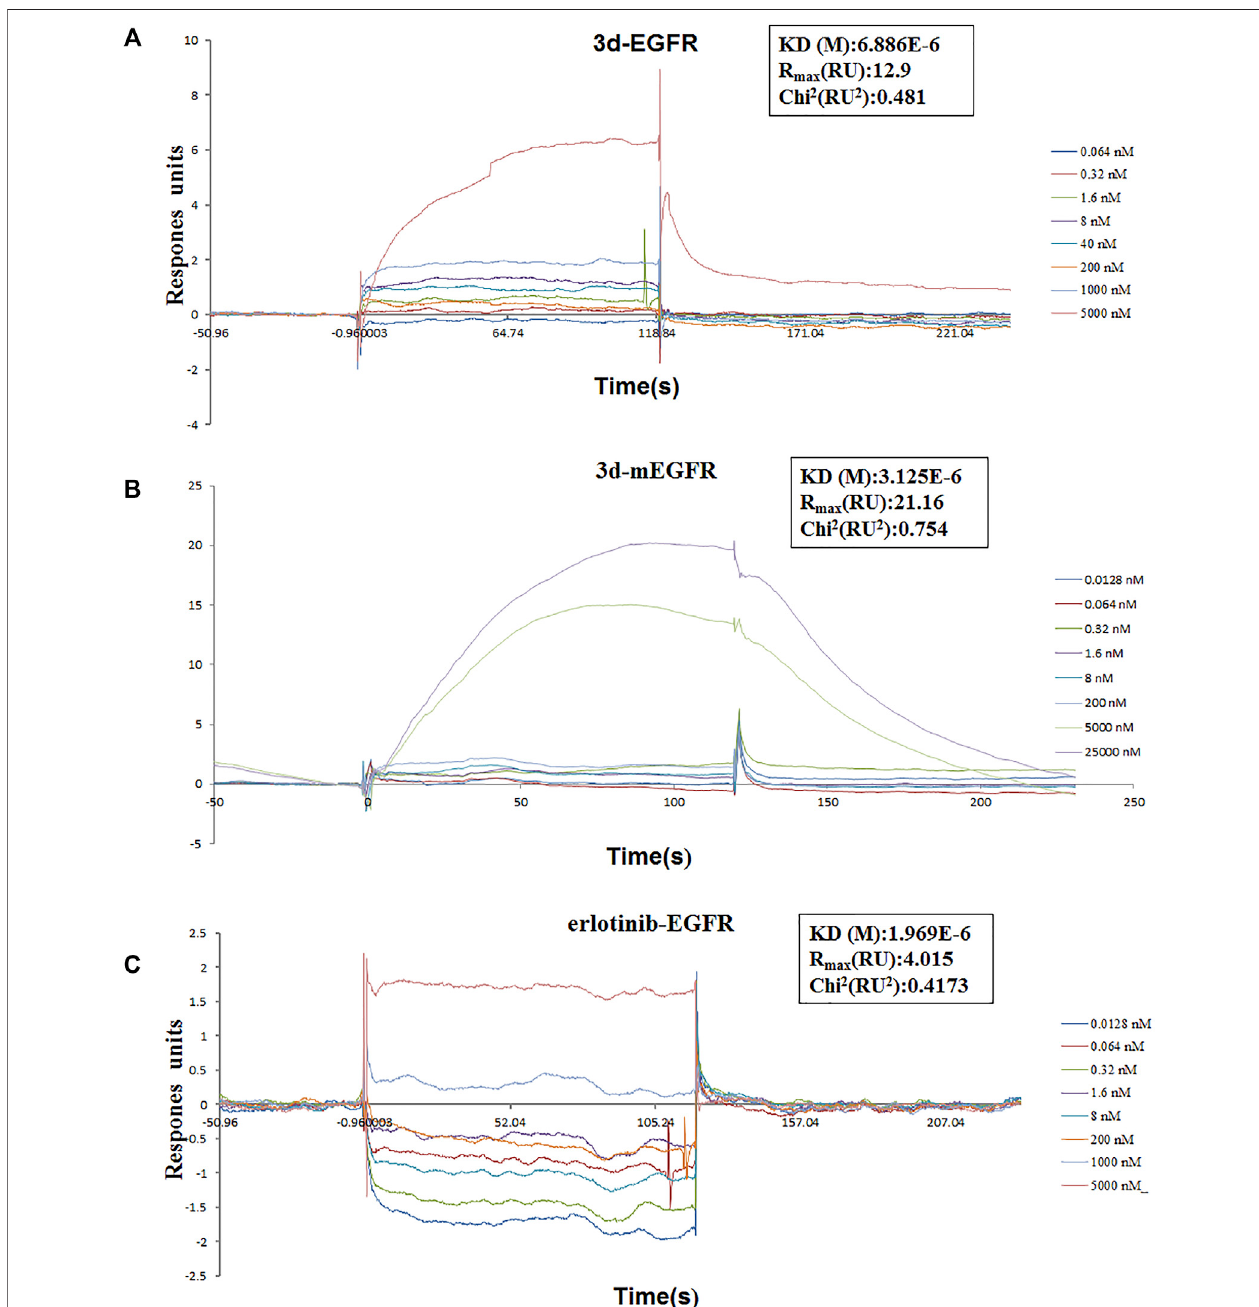
FIGURE8| Surfaceplasmonresonanceexperimentsof 3d anderlotinib. (A) Bindingsensorgramsfor 3d interactionwithimmobilizedwild-typeofEGFR.TheK D (M) valuebetween 3d andwild-typeEGFRis6.88×10 − 6 . (B) Bindingsensorgramsfor 3d interactionwithimmobilizedmutantproteinofEGFR.TheK D (M)valuebetween 3d and mutant protein EGFR is 3.12 × 10 − 6 . (C) Binding sensorgrams for erlotinib interaction with immobilized wild-type of EGFR. The K D (M) value between erlotinib and wild-type EGFR is 1.97 × 10 − 6 .